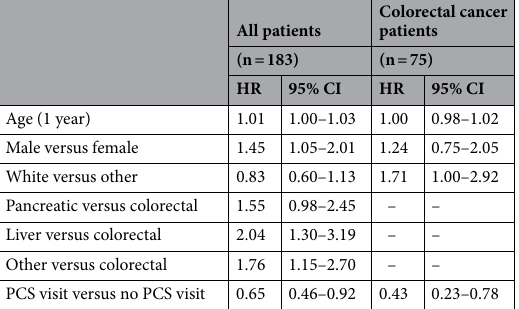
Table 3. Multivariable model of survival among patients referred to palliative care services at a single institution, 2014–2018. PCS Palliative care services, HR Hazard ratio, CI Confidence interval.